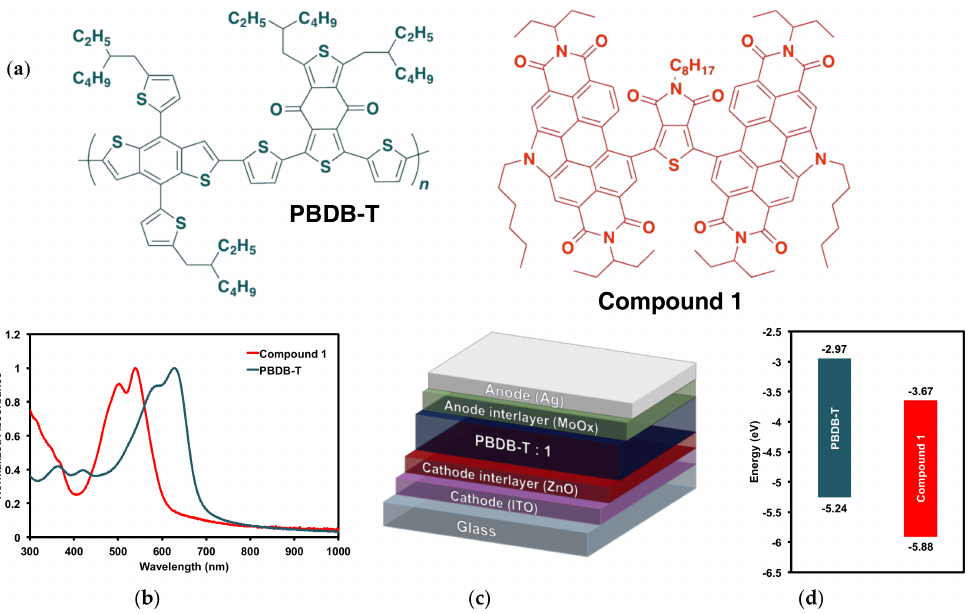
Figure 7. ( a ) PBDB-T donor polymer PBDB-T and (PDI) 2 octTPD ( 1 ) acceptor; ( b ) thin film absorption profiles; ( c ) device architecture; ( d ) electronic energy levels.